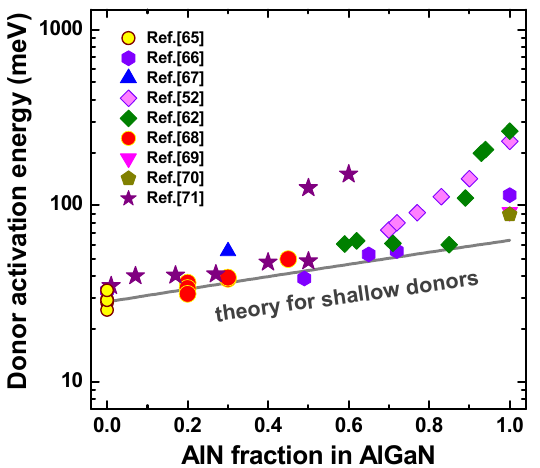
Figure 4. Experimental low-concentration activation energies of the Si donor vs. AlGaN composition corrected for particular donor concentrations (symbols). The grey line is the theoretical curve calculated for shallow-donor states.